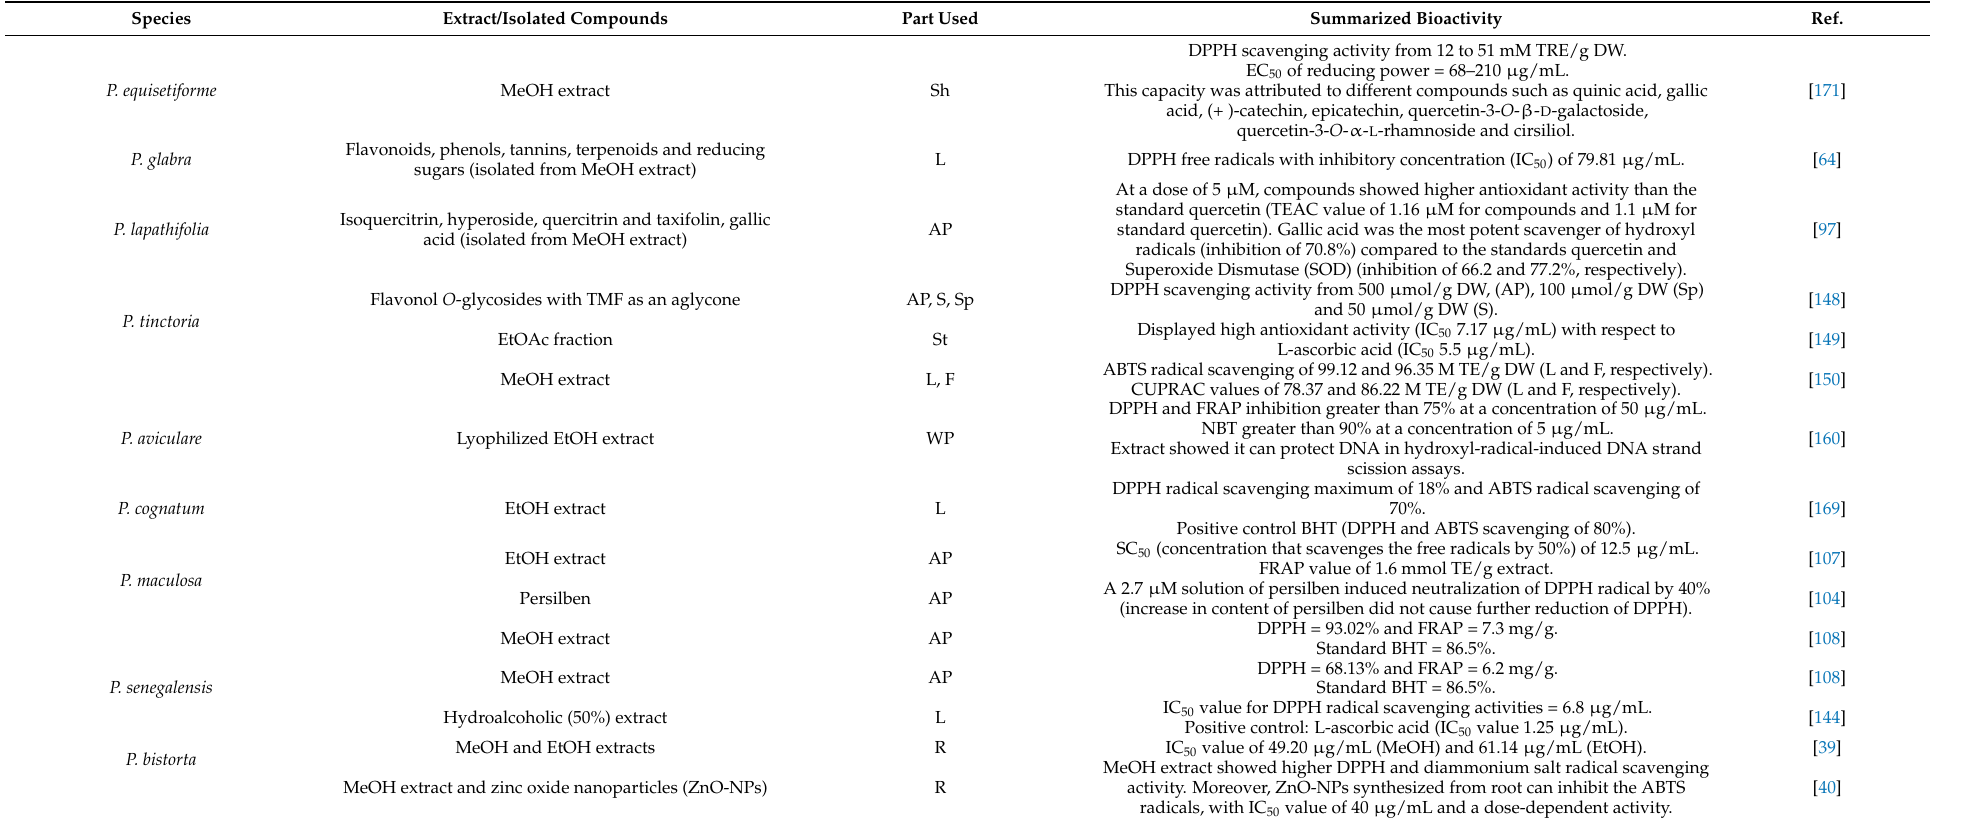
Table 3. Antioxidant activity of Persicaria and Polygonum species. Extracts, compounds, part of plant used, antioxidant activity and references are shown. Extracts: DCM (dichloromethane); EtOH (ethanol); MeOH (methanol); EtOAc (ethyl acetate); But (butanol). Part used: L (leaves); F (flowers); R (roots); Sp (sprouts); Sh (shoots); S (seeds); St (stems); Rh (rhizomes); WP (whole plant); AP (aerial parts). Antioxidant assays: DPPH (2,2-diphenyl-2-picryl hydroxyl); TEAC (Trolox Equivalent Antioxidant Capacity); CUPRAC (Cupric Reducing Antioxidant Capacity); ABTS ((2,2 (cid:48) -azino-bis(3-ethylbenzothiazoline-6-sulfonic acid)); NBT (Nitroblue tetrazolium); FRAP (Ferric Reducing Antioxidant Power); ORAC (Oxygen Radical Absorbance Capacity assay); CCA (Copper Chelating